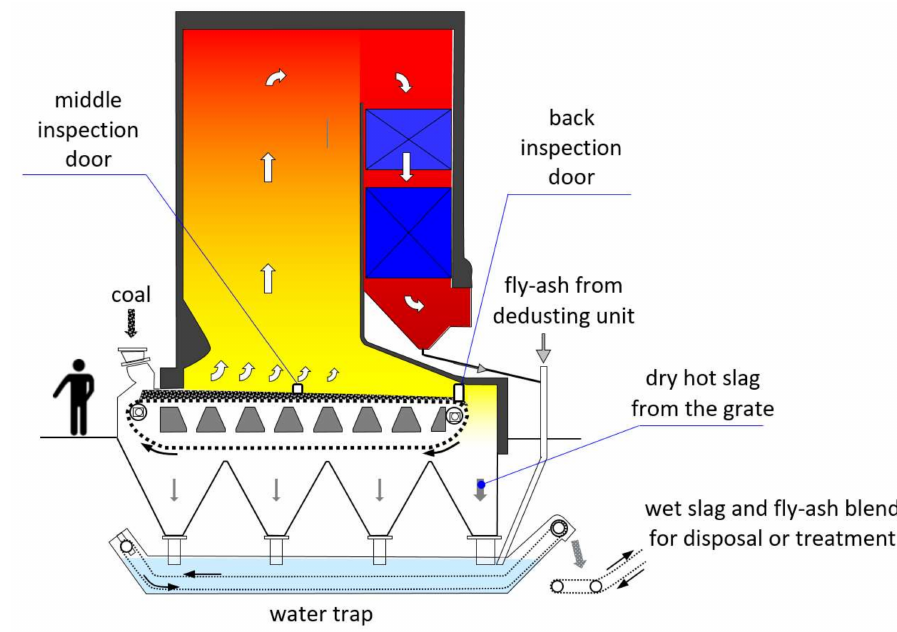
Figure 2. Schematic layout of the stoker-boiler under investigation with a deslagger with tub fueled with water (water trap at the